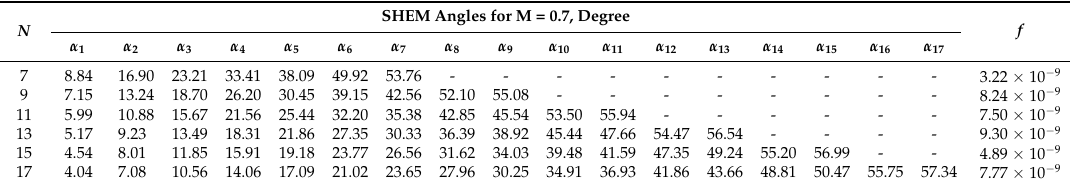
Table 6. SHEM Angles for N = 7, 9, 11, 13, 15, and 17, and M = 0.7 Optimized by PSO Usıng the Generalized Initialization Procedure in Table